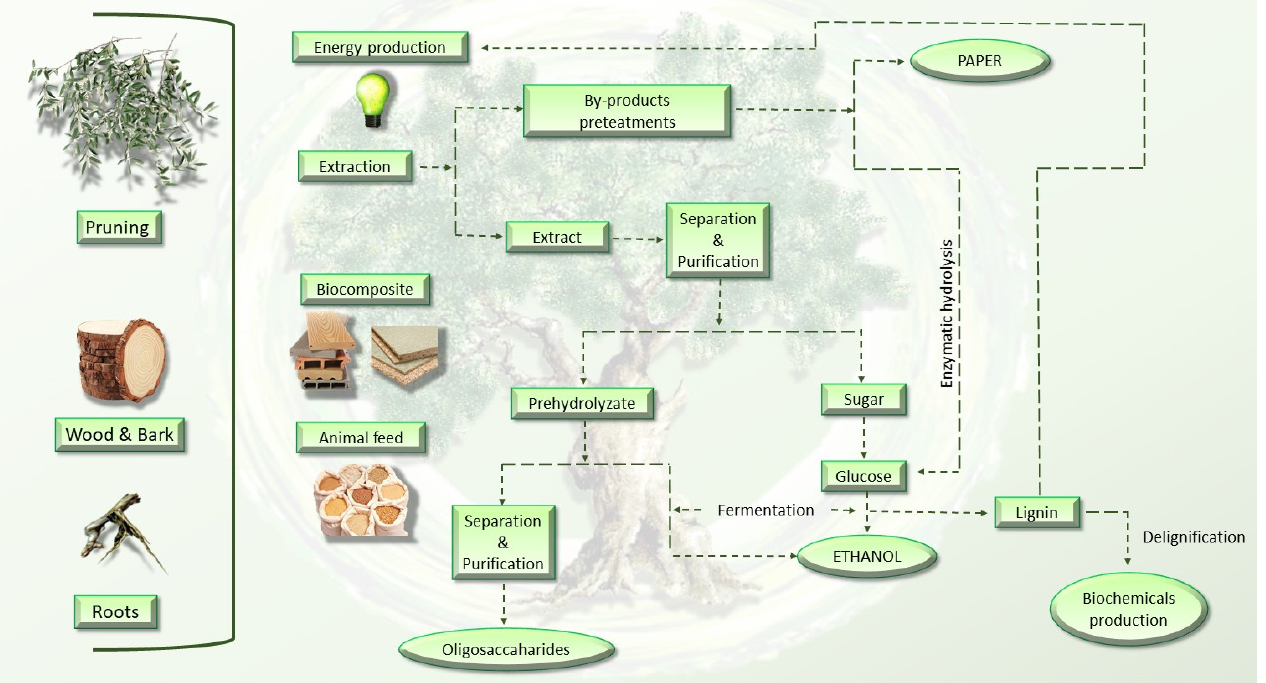
Figure 6. Graphical representation of O. europaea agro-industrial by-product recycling processes .